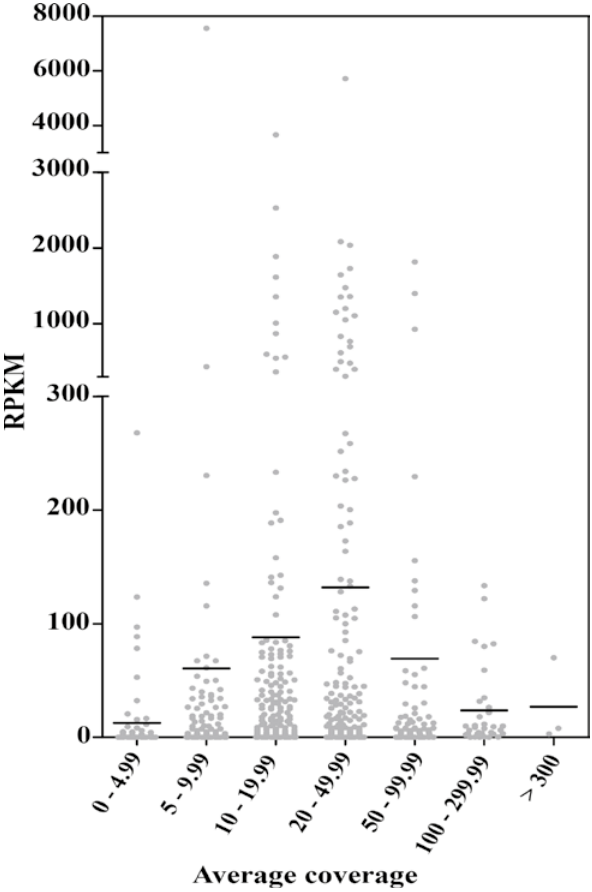
Fig. 3. Relationship between average coverage and RPKM for each of 828 full-length LTR-REs of P. trichocarpa .